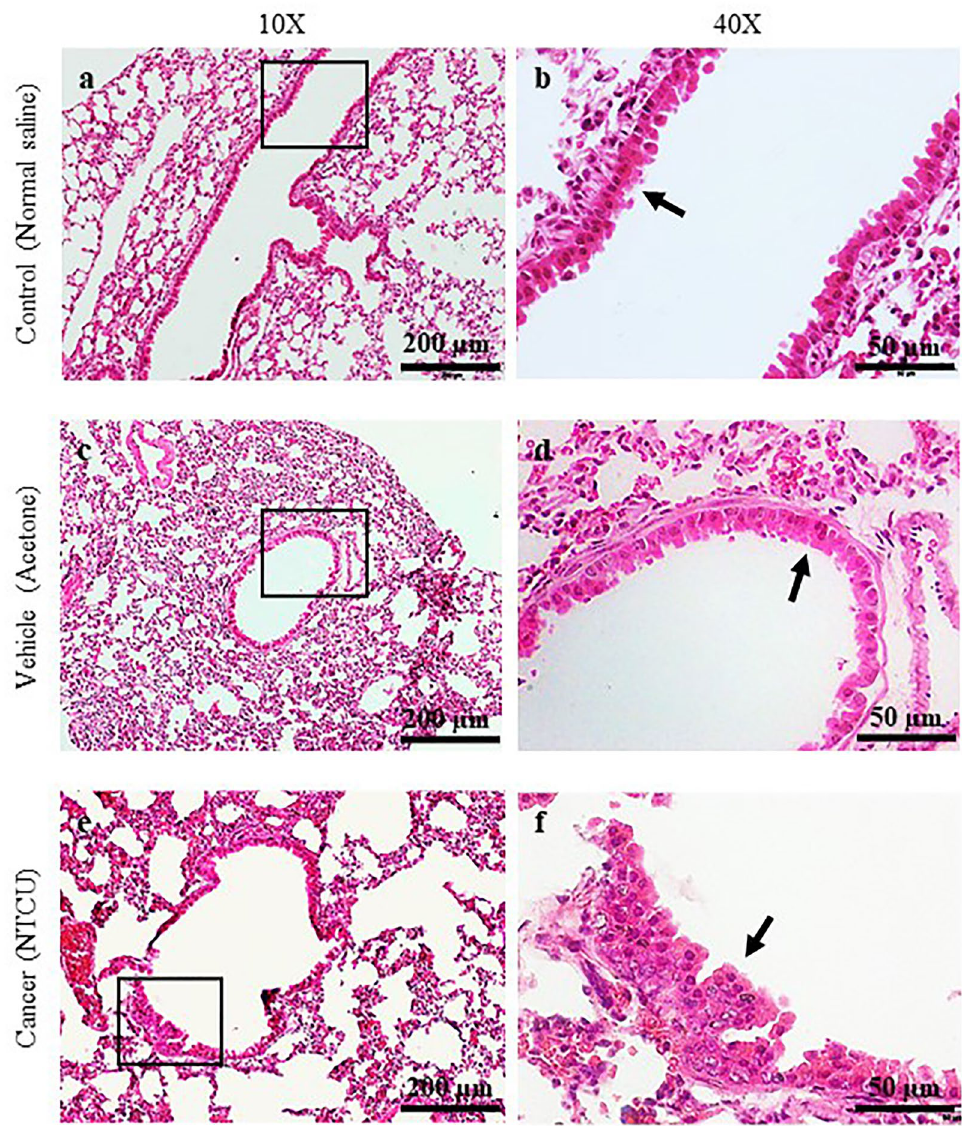
Figure 1. H&E Staining of the bronchial area after 15 weeks of treatment with normal saline ( a and b ), acetone ( c and d ), and NTCU ( e and f ). Arrows in ( b ) and ( d ) show normal bronchial epithelial cells. Arrow in f shows hyperplastic epithelial